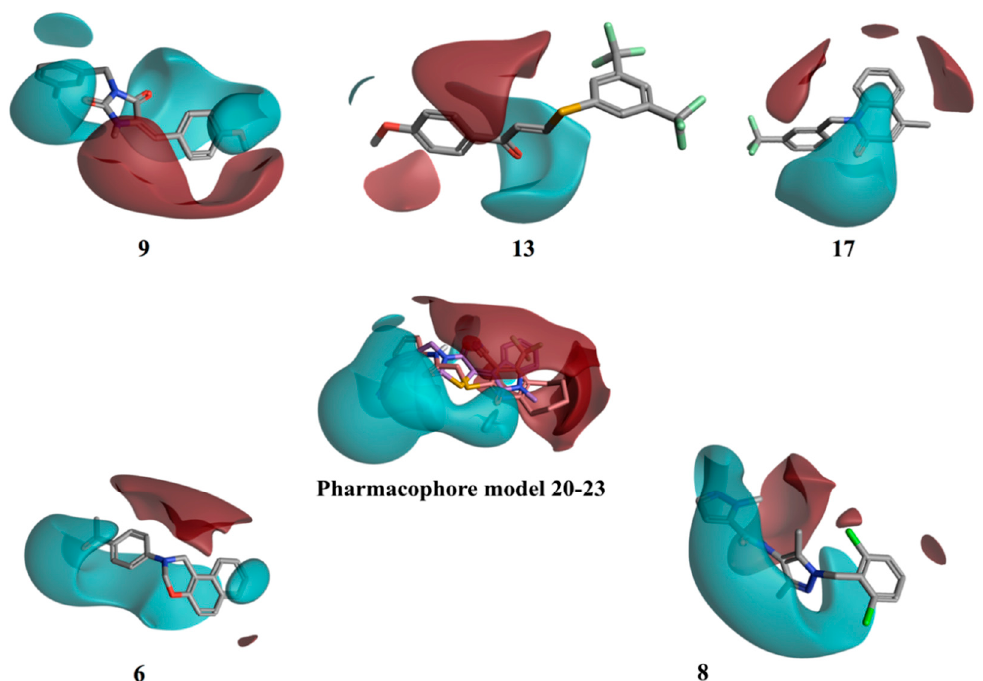
Figure 9. 3D electrostatic–hydrophobic and shape properties. The pharmacophore model generated from 20 and 23 presents two well distinct and separated regions: a positive electrostatic region, in red, and a negative electrostatic region, in cyan. The rest of the compounds were aligned with the pharmacophore, using a field-based alignment approach. Results for 6 and 8 are shown as an example of compounds matching the pharmacophore.